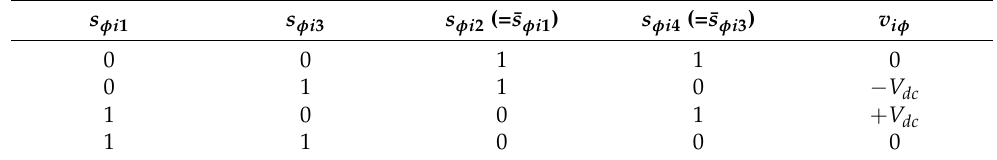
Figure 1. Three-phase reactive load ( R L - L L ) fed by a three-phase seven-level CHB. Table 1. Possible voltages values for v i φ